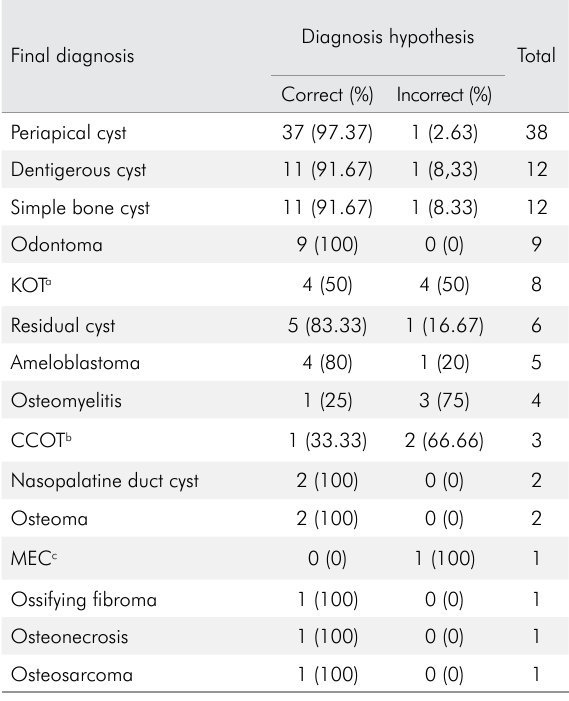
Table 2. Comparison between the diagnosis hypothesis to the final